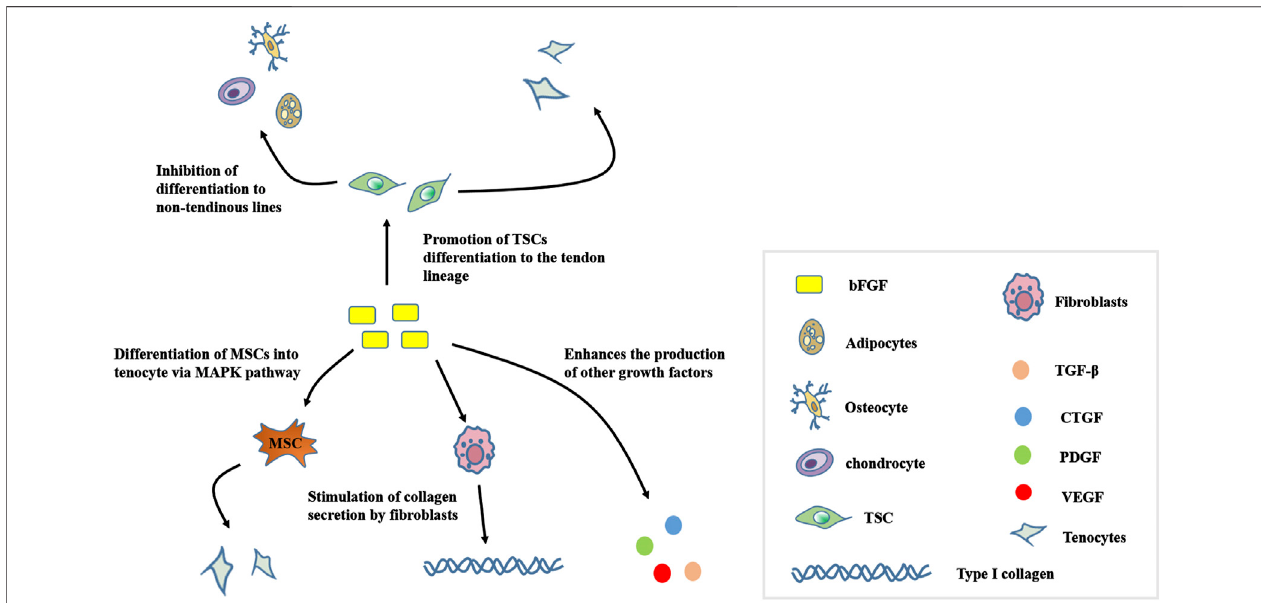
FIGURE3| MechanismofactionforbFGFintendonstemcells,mesenchymalstemcells,and fi broblasts.bFGF,Basic fi broblastgrowthfactor;TSC,tendonstem/ progenitor cell; TGF- β , transforming growth factor beta; CTGF, Connective tissue growth factor; PDGF, platelet-derived growth factor; VEGF, vascular endothelial growth